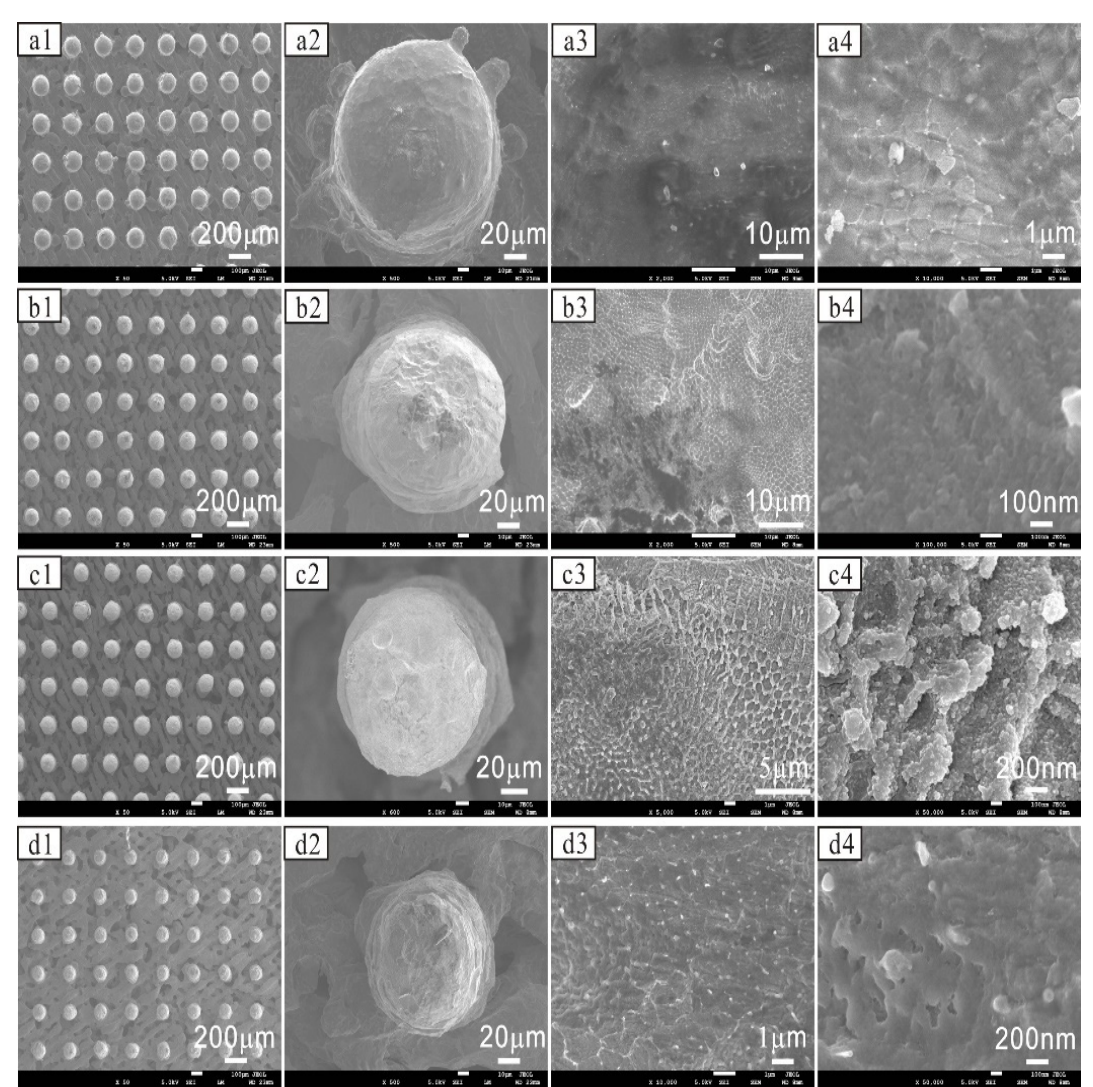
Figure 3. The micro-topography of the sample surface at different times of corrosion. ( a ) 5 h; ( b ) 10 h; ( c ) 15 h; ( d ) 20 h.